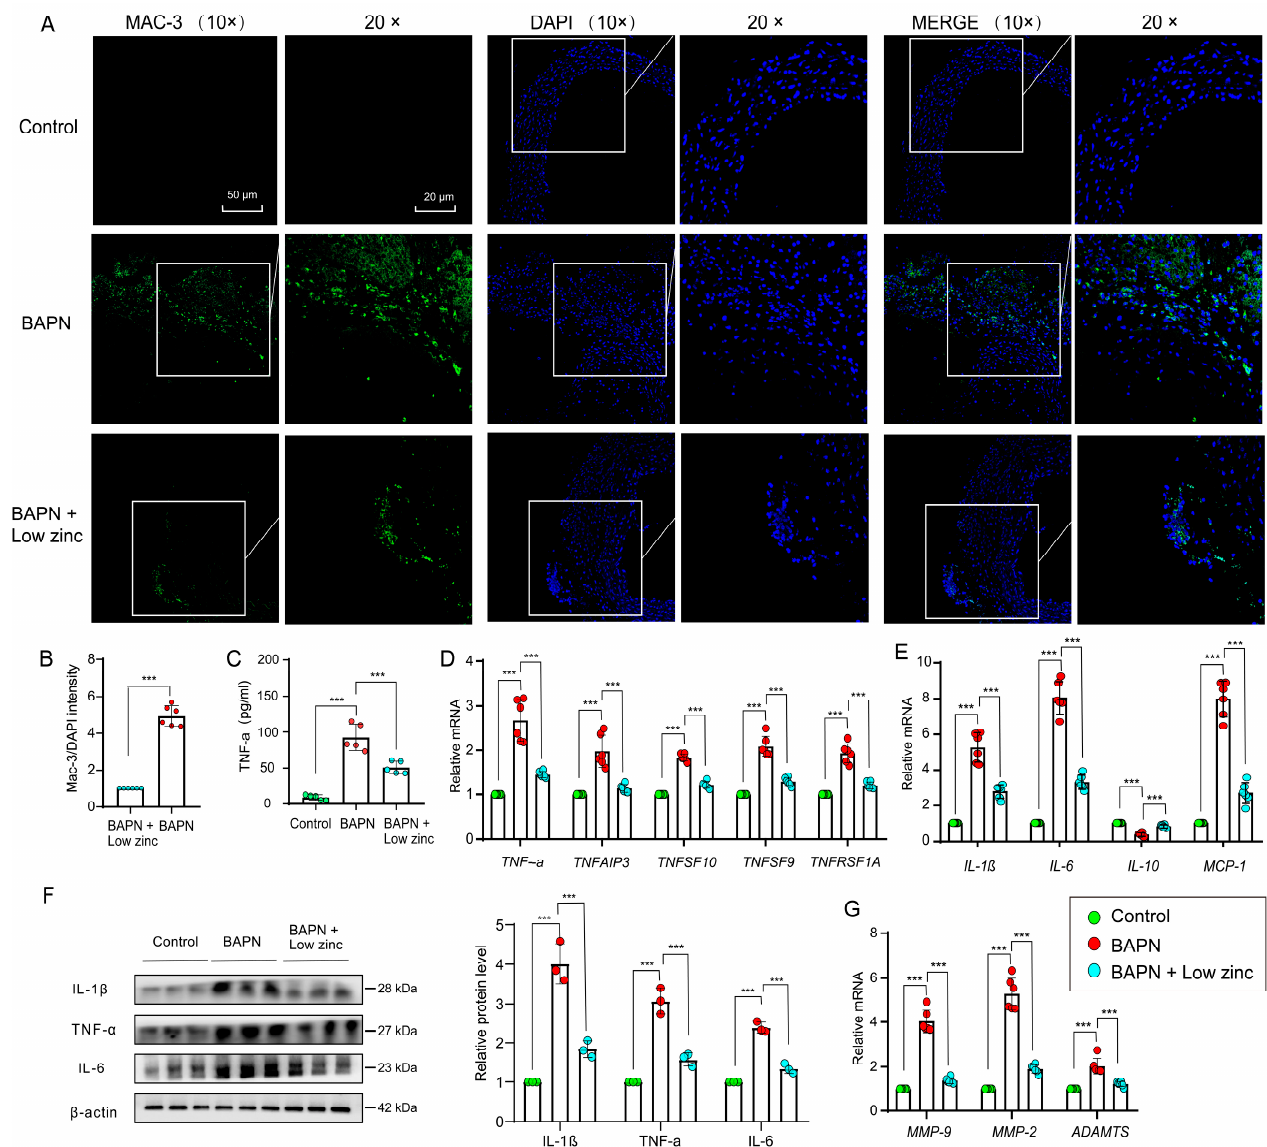
Figure 5. Low zinc inhibited TAD by down-regulating in fl ammation. ( A ) Representative confocal images of mice aorta stained with Mac-3 (green) and DAPI (blue) (scale bars, 50 µ m for 10 magni fi cations; 20 µm for 20 magni fi cations). ( B ) Quanti fi cation of Mac-3 levels ( n = 6 per group); by one-way ANOVA (*** p < 0.001). ( C ) The expression level of TNF- α in mice serum ( n = 5 per group), by one-way ANOVA (*** p < 0.001). ( D ) Relative mRNA levels of TNF- α , TNFAIP3 , TNFSF10 , TNFSF9 and TNFSF1A of tumor necrosis factors in mice aorta ( n = 6 per group); by two-way ANOVA (*** p < 0.001). ( E ) Relative mRNA levels of IL-1 β , IL-6 , IL-10 and MCP-1 of interleukin and chemokines in mice aorta ( n = 6 per group); by two-way ANOVA (*** p < 0.001). ( F ) The protein levels (left column is western blot result, right column is quantitative analysis) of selected typical proin fl ammatory factors (IL-1 β , TNF- α and IL-6) in mice aorta ( n = 3 per group); by two-way ANOVA (*** p < 0.001). ( G ) Relative mRNA levels of MMP-9 , MMP-2 and ADAMTS of extracellular matrix enzymes in mice aorta ( n = 6 per group); by two-way ANOVA (*** p < 0.001). All samples were collected after the animal experiment ended (BAPN-induced 30 days).